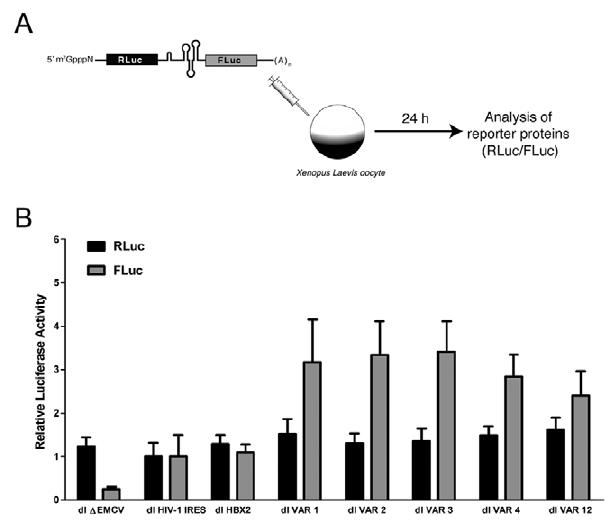
Figure 3. Assessment of IRES activity present within the HIV-1 VAR 5 9 UTR in Xenopuslaevis oocytes. (A) Schematic representation of the experimental procedure. (B) Capped and polyadenylated RNA corresponding to the dl ?EMCV [10,25], dl HIV-1 IRES [10,19,20], dl HBX2 (pLAI), or the different dl VAR 5 9 UTR (VAR 1, VAR 2, VAR 3, VAR 4, VAR 12) vectors (6.25 ng) were microinjected (50 nl final volume) into Xenopus laevis oocytes as previously described [19,20,23]. Oocytes were harvested 24 hr after microinjection, processed, and Renilla luciferase (RLuc) and Firefly luciferase (FLuc) activities were determined as described in Materials and Methods. Data are expressed as relative luciferase activities, the RLuc and FLuc activities of the dl HIV-1 IRES, the control bicistronic RNA harboring the 5 9 UTR of pNL4.3 in the intercistronic region between RLuc and FLuc [10], was arbitrarily set at 1. Each value is the mean + /- SEM from at least 3